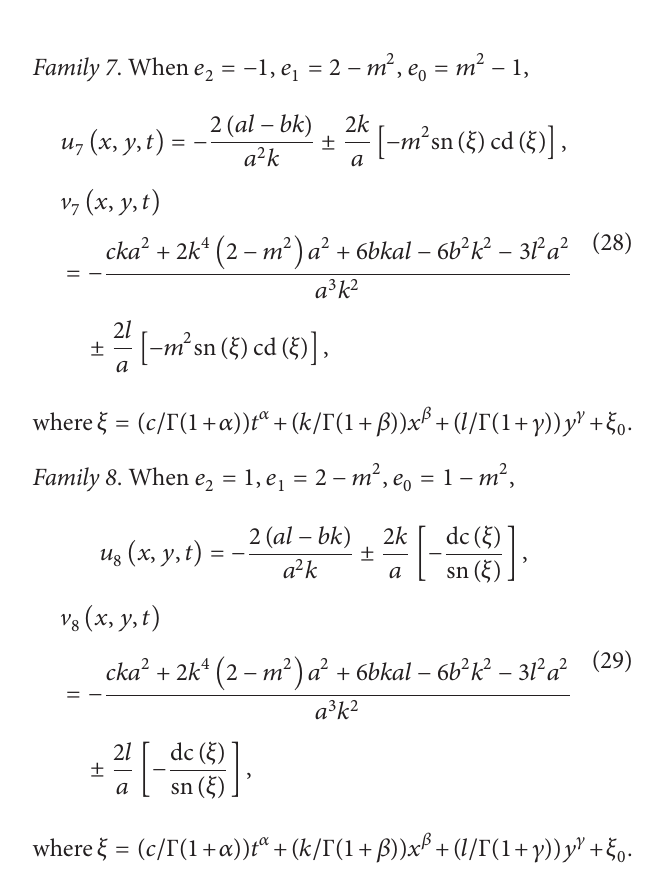
Family 5 . When 𝑒 2 = 𝑚 2 , 𝑒 1 = −(1+𝑚 2 ) , 𝑒 0 = 1 , the